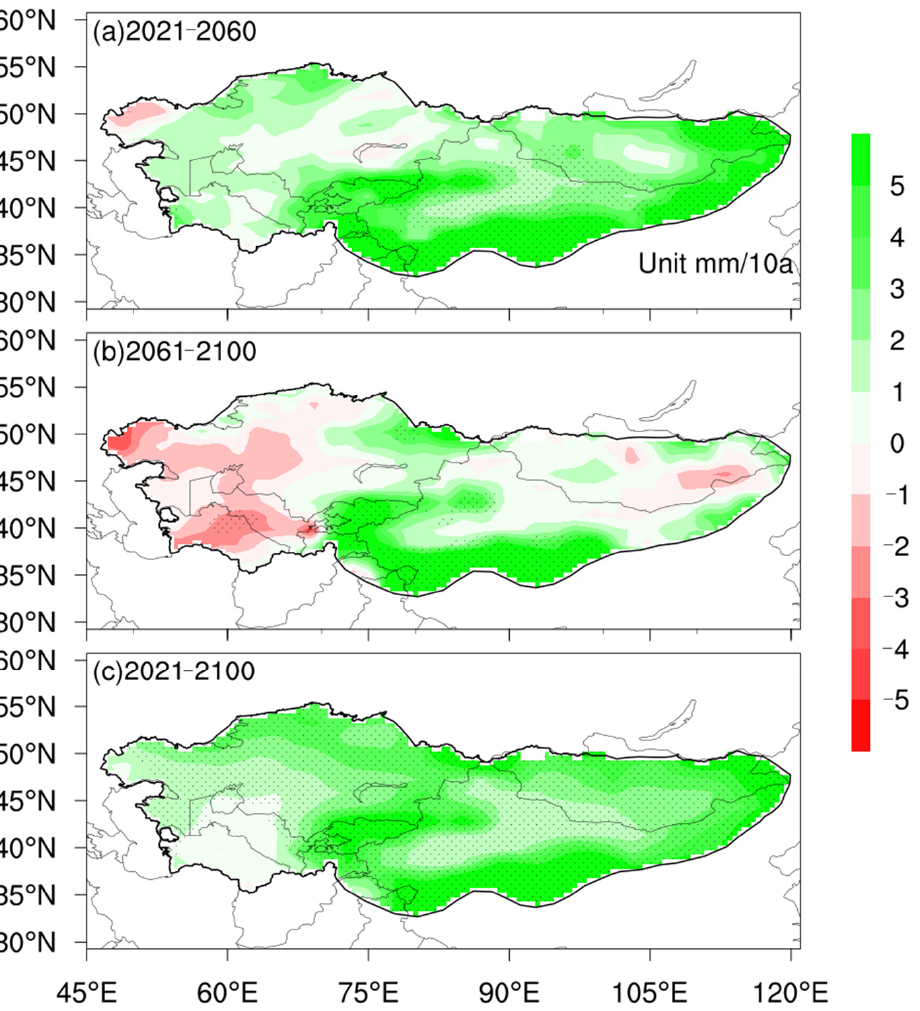
Figure 12. Variation rates of multi-mode ensemble precipitation in 2021–2060 ( a ), 2061–2100 ( b ), and 2021–2100 ( c ). Shading indicates a passed 0.05 significance test.